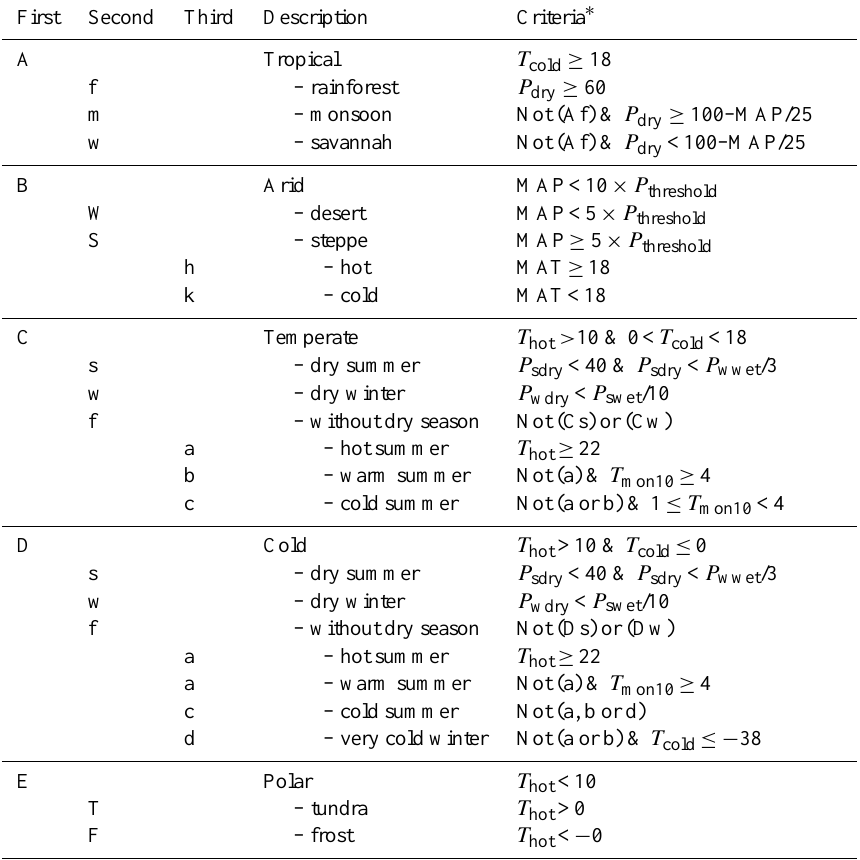
Table 3. Description of Köppen climate symbols and defining criteria (from Peel et al., 2007). First Second Third Description Criteria ∗ A Tropical